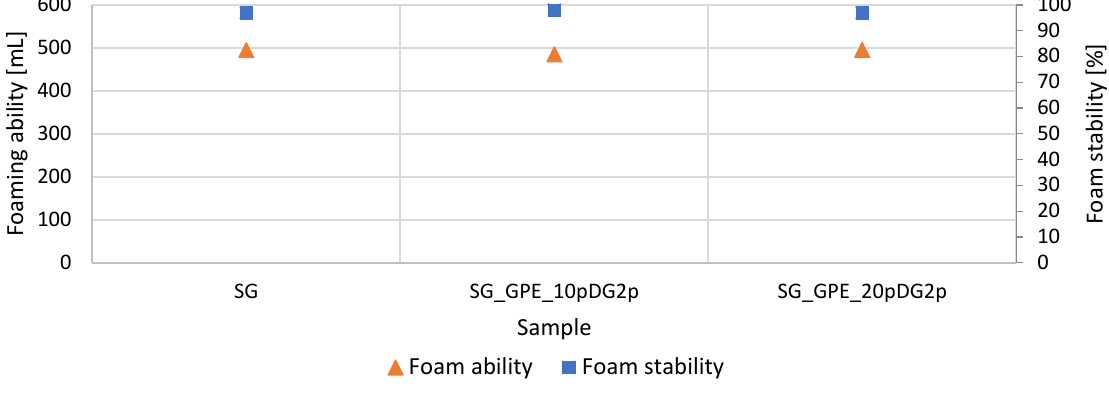
Figure 9. Foam properties.